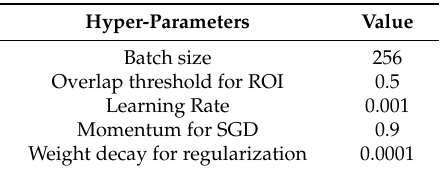
Table 1. The hyper-parameters from